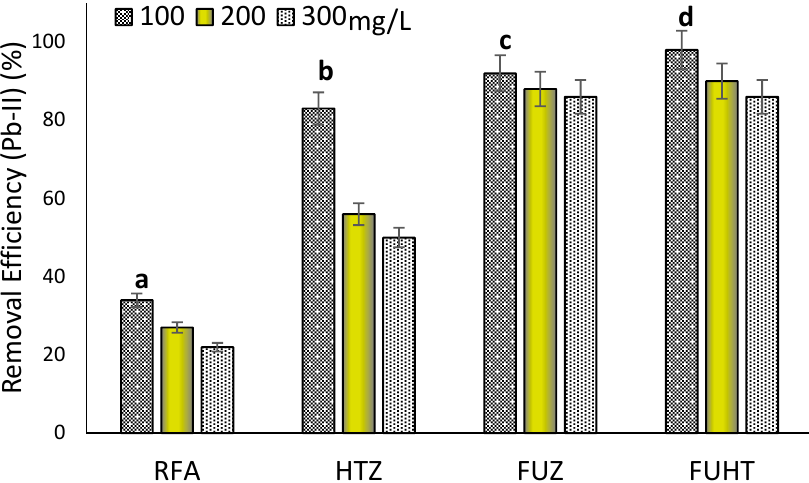
Figure 7. Effects of metal ion concentration of Pb (II) on its removal efficiency at pH ≈ 8, 1 g/100 mL mass of adsorbent (RFA and Na-zeolites), and 30 min contact time at 25 °C. Notes: a,b,c,d shows significant ( p < 0.05) differences among different zeolite samples.